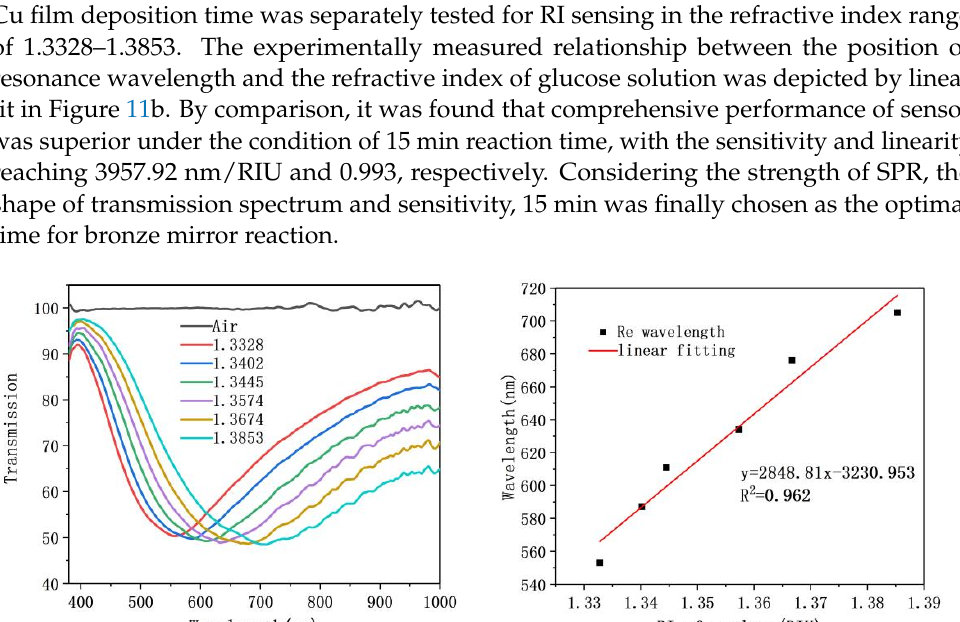
Figure 10. ( a ) Resonance spectrum of fiber/Ag film SPR sensor as the refractive index of the analyte increases; ( b ) The sensitivity fitting curve.